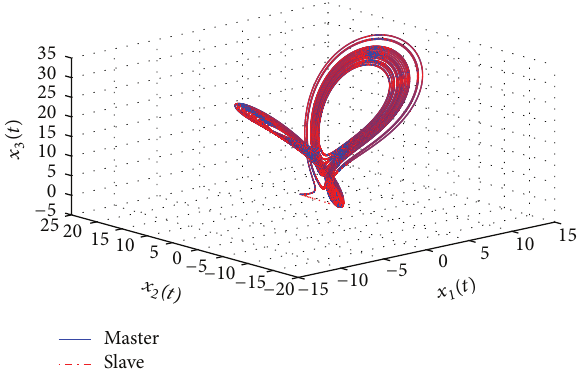
Figure 13: Plots of ‖Φ(𝑡)‖ (blue line)